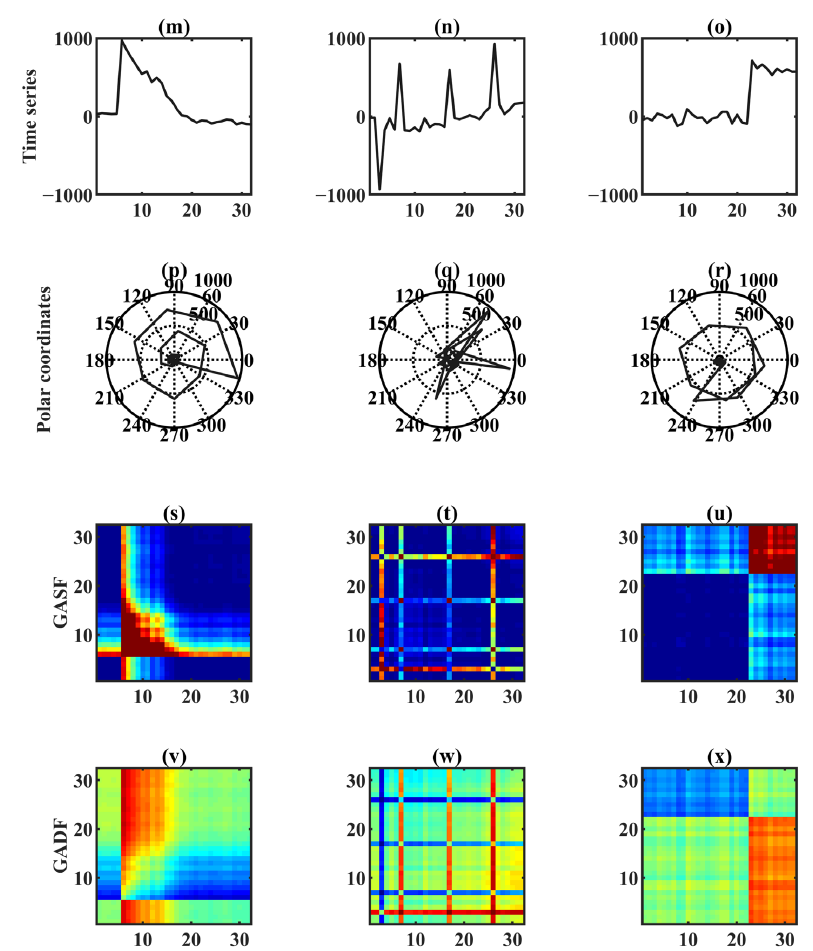
Figure 4. The shapes of MT noise-free data and harmonic, square, triangle, impulse and step noises in different coordinates. ( a – c ) and ( m – o ) in the Cartesian coordinate. ( d – f ) and ( p – r ) in the polar coordinate. ( g – i ) and ( s – u ) in the GASF. ( j – l ) and ( v – x ) in the GADF. Red to Blue: It represents the amplitude is from large to small.